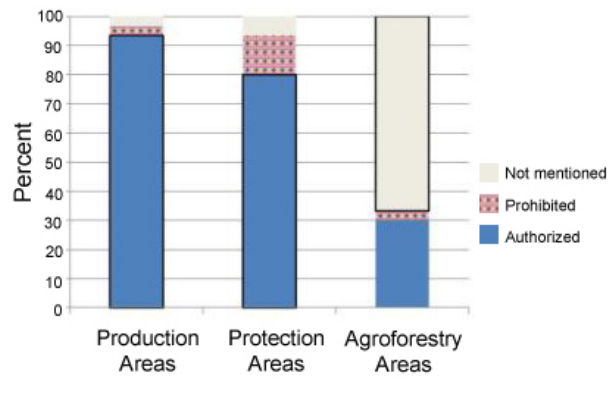
Fig. 3 . Regulation of hunting in 30 forest management